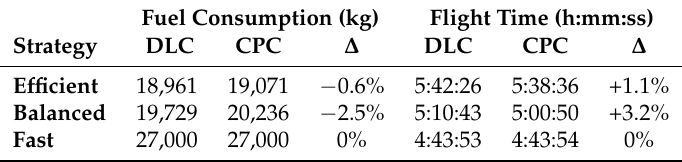
Table 7. The design mission performance of the PrP using DLC w.r.t. its performance using CPC. Fuel Consumption (kg) Flight Time (h:mm:ss) Strategy DLC CPC